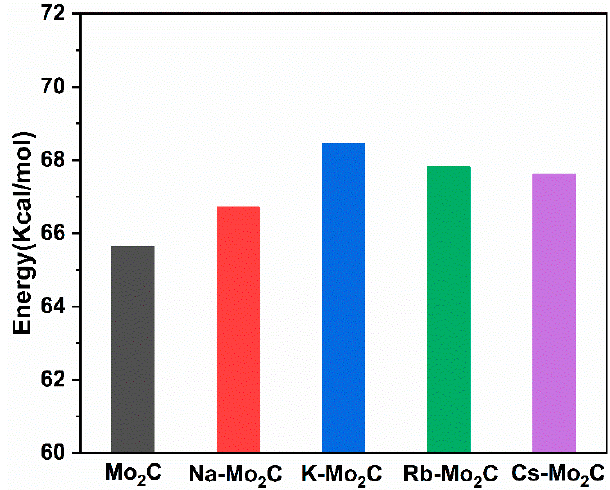
Figure 7. The desorption energy of CO on bare and X-Mo 2 C, where X = Na, K, Rb, Cs.